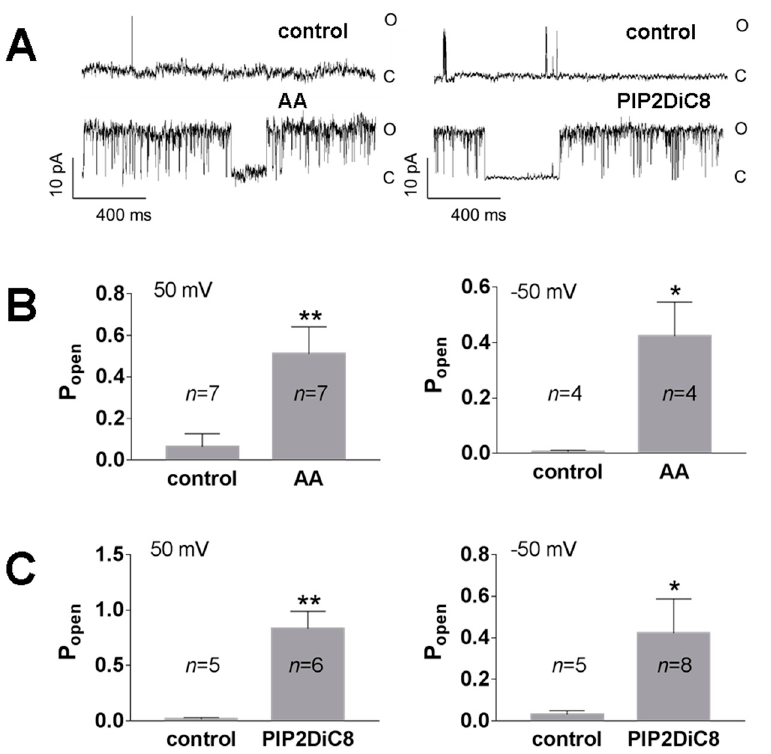
Figure 3. TREK-2 channel activators AA and PI(4,5)P2DiC8 induced an increase in P open in excised patches with low spontaneous activity. ( A ) Original recordings at the control and experimental conditions at 50 mV; the left traces represent the activity of a TREK-2-like channel in the control solution (0 mM Ca 2+ ) and after the change to the solution containing AA (0 mM Ca 2+ , 10 µ M AA); and the right traces represent the experiment in which the control solution (0.1 mM Ca 2+ ) was exchanged for the solution with PIP2DiC8 (0.1 mM Ca 2+ , 10 µ M PI(4,5)P2DiC8). Low-pass filters were set at 0.5 kHz. ( B ) Mean P open for the experiments with 10 µ M AA at two membrane potentials: